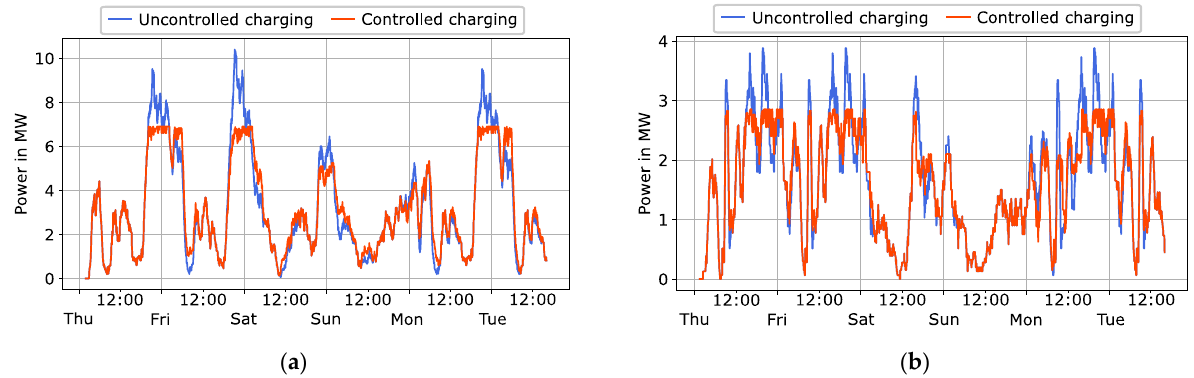
Figure 5. Load profile for the two analyzed charging management scenarios from Thursday to Tuesday for ( a ) BD1 and ( b ) BD2.